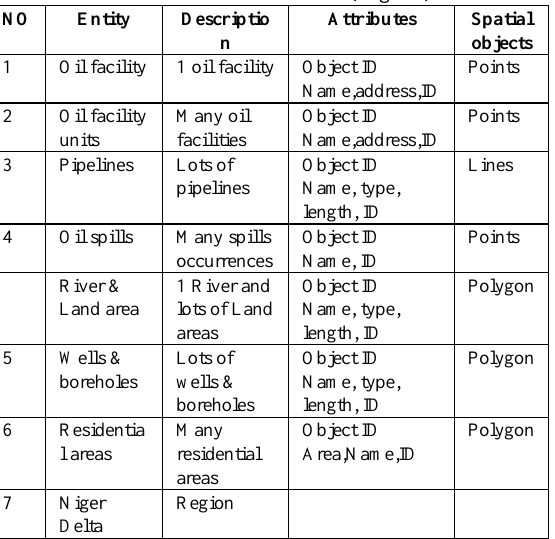
Figure 8. Logical model design of oil spills pollution affecting water quality Table 4.0 Master Data list